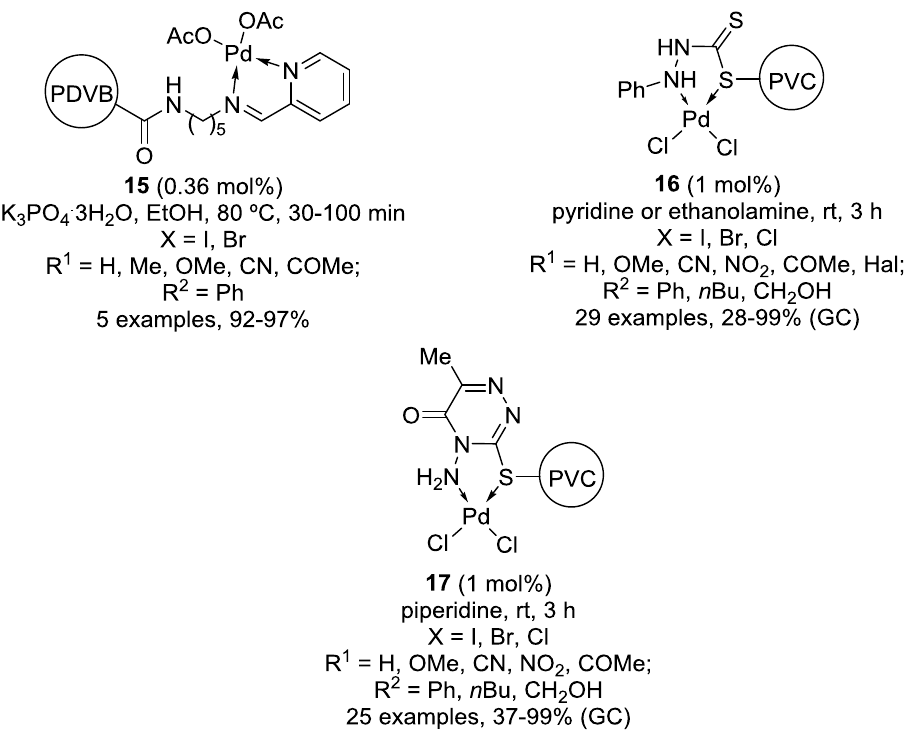
Figure 5. Organic polymer-supported palladium catalysts for the Sonogashira reaction. Conditions, substrate scope and yield range (Scheme 2).